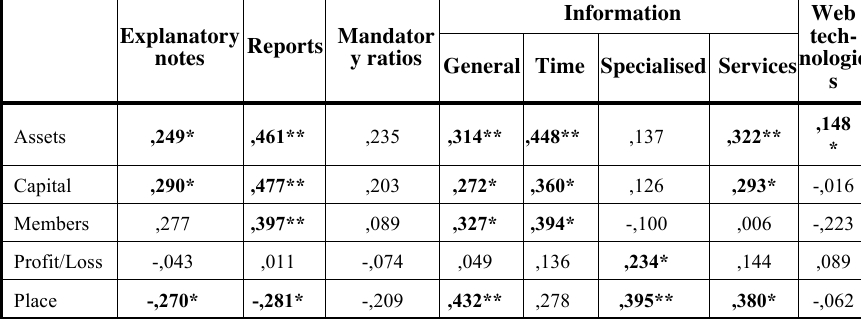
Table 7. Relationship of e-transparency measures and CUs’ characteristics Explanatory